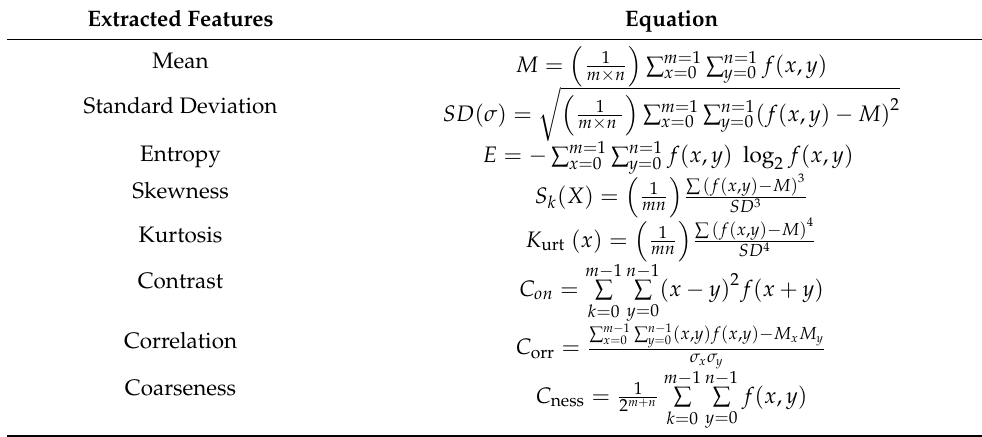
Table 5. Gives the statistical parameters for calculating feature extraction.